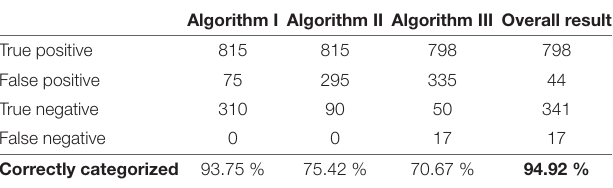
TABLE 3 | Results of the algorithms with respect to the training data set.